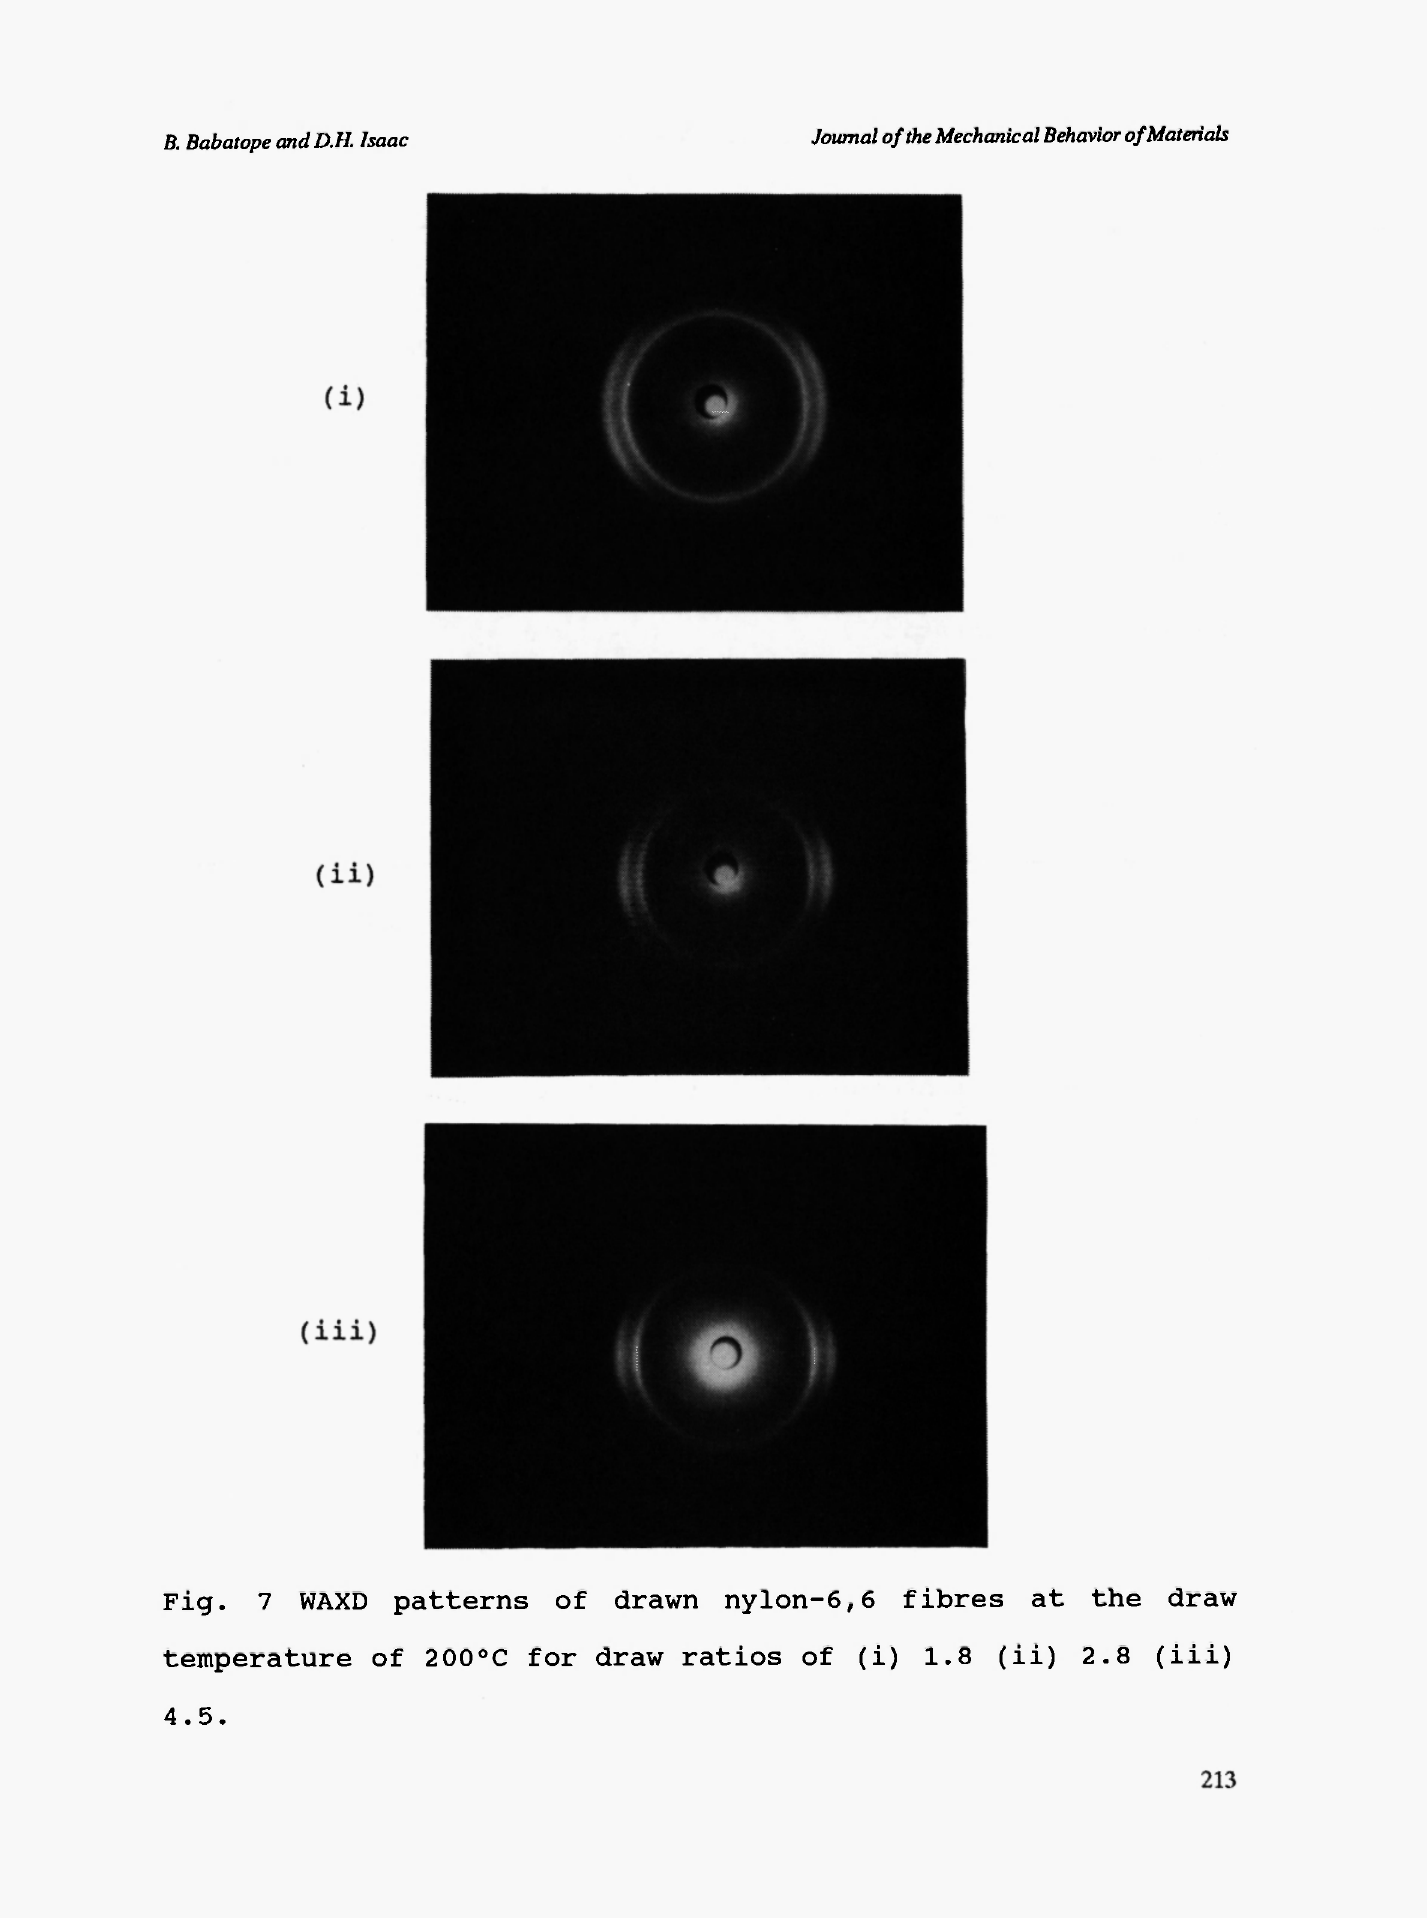
Fig. 7 WAXD patterns of drawn nylon-6,6 fibres at the draw temperature of 200°C for draw ratios